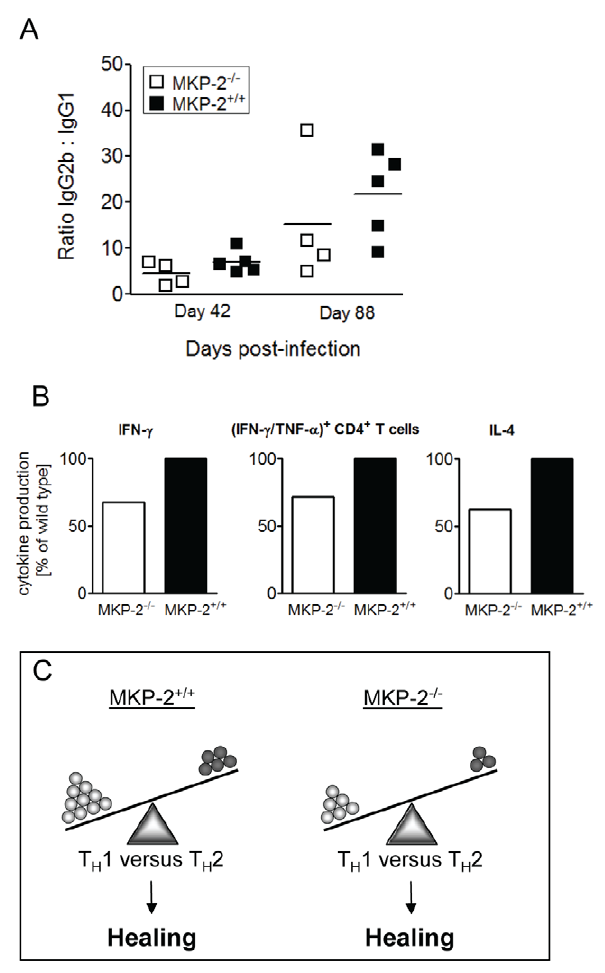
Figure 5. A sustained T H 1/T H 2 balance in MKP-2 deficient mice is due to general T cell hypo-responsiveness against L.major . Antibody titres for IgG2b were divided by respective titres for IgG1 for each individual mouse and for both time points. Higher values are indicative for higher IgG2b levels and lower values reflect a higher IgG1 response. The bar indicates the median of each group (A). The percent reduction of the mean for each measured parameter (IFN- c , IL-4 and IFN- c /TNF- a + CD4 + T cells) of MKP-2 2 / 2 mice was calculated against the mean values of MKP-2 + / + mice (=100%) (B). If both immune responses (T H 1, (IFN- c /TNF- a + CD4 + T cells and IFN- c ) versus T H 2 (IL-4) are reduced to a similar extend (B), the balance between disease promoting T H 2 and the protective T H 1 response is not disturbed. Since the mice are on a C57BL/6 background the T H 1 response will outweigh the T H 2 response and consequently result in a healing phenotype (C).